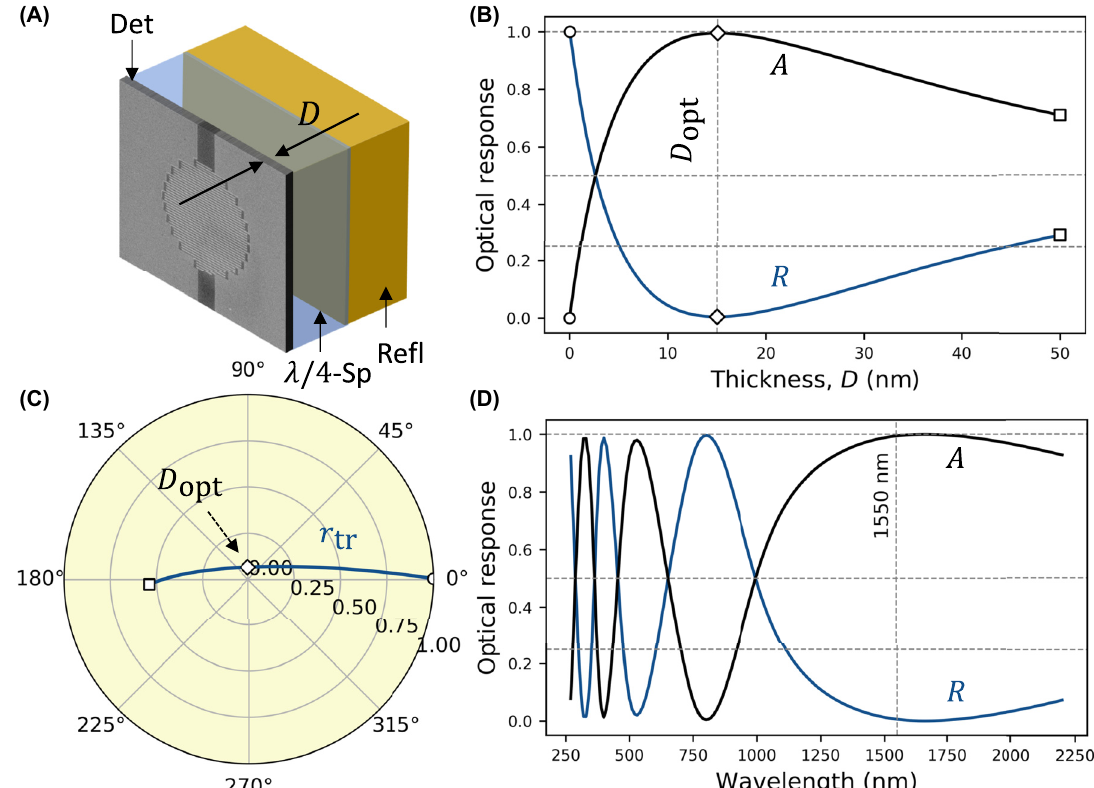
Figure 2: Salisbury screen SNSPD design. (A) The nanowire detecting layer (Det) is separated from the reflector (Refl) by a 𝜆 ∕ 4-spacer, thus placing the nanowire at the anti-node of the standing wave. In the calculations, the mirror is treated as a semi-infinite layer with a reflectivity of 99.9%. (B) The optical response of the structure-reflection R and absorption A , is calculated while sweeping the thickness D of the nanowire. (C) The corresponding amplitude reflection r coefficient is shown in the circular diagram, where the radial (angular) coordinate defines the magnitude (phase) of r . In (B) and (C), empty circles and squares mark the beginning ( D = 0 nm) and end ( D = 50 nm) of the deposition, respectively, while diamonds mark the optimal = 15 nm. The nanowires are assumed to thickness. (D) The reflection R and absorption A spectra are calculated for an optimal SNSPD thickness of D ) ( opt 2 at 1550 = be carved out of a NbTiN film with permittivity 𝜀 4 . 21 + i 3 . 87 film